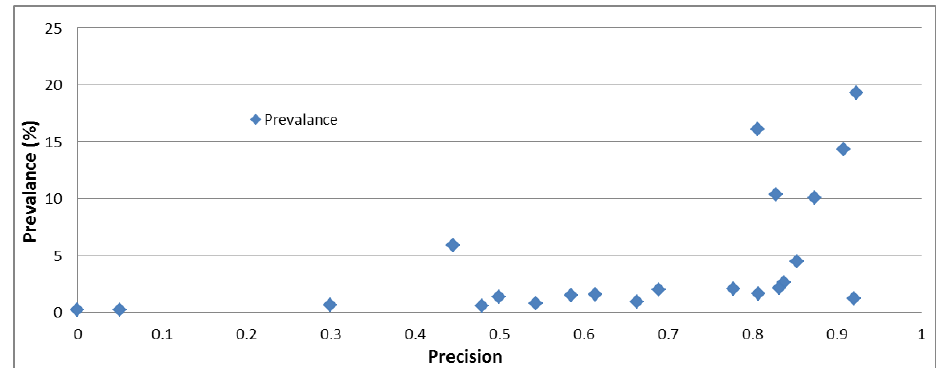
Figure 1. Correlation between the precision and prevalence of a